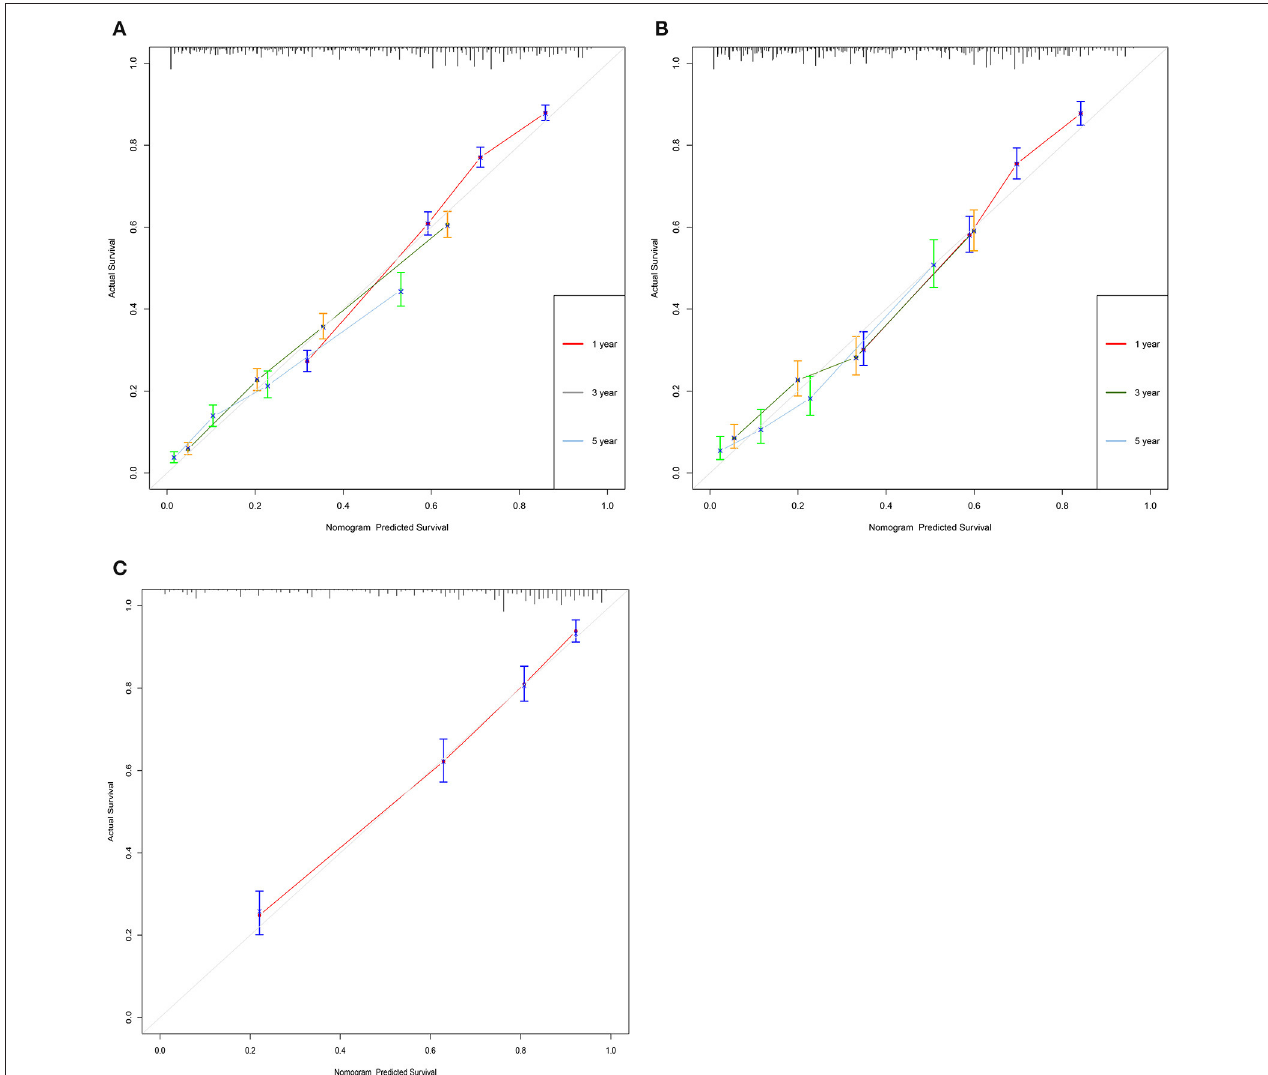
FIGURE 3 | Calibration curves of the nomogram. (A) For 1-, 3-, and 5-year OS in training cohort; (B) for 1-, 3-, and 5-year OS in validation cohort; and (C) for 1-, 3-, and 5-year OS in validation